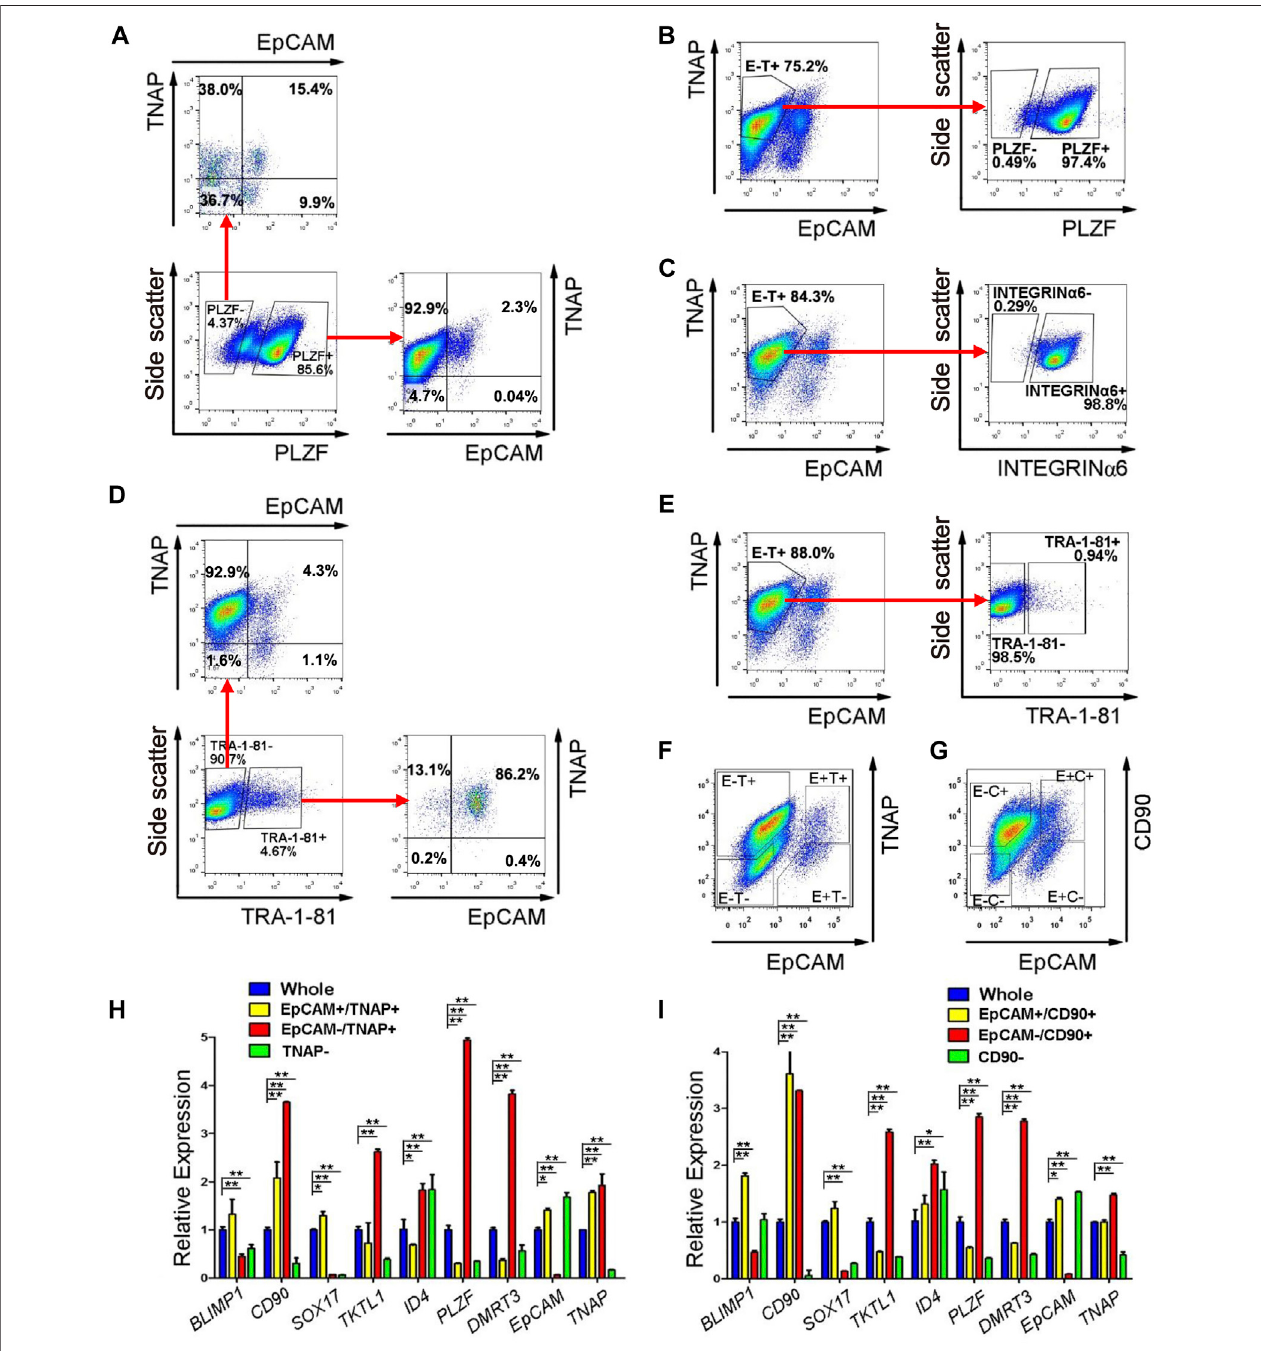
FIGURE 4 | EpCAM-/TNAP+ population is enriched with SLCs differentiated from human PSCs. (A) Flow cytometry analyses of EpCAM and TNAP expression in PLZF positive and negative populations from PSCs. (B,C,E) Percentage of PLZF (B) , INTEGRIN α 6 (C) , and TRA-1-81 (E) in EpCAM-/TNAP+ population differentiated fromhumanPSCs,analyzedby fl owcytometry. (D) FlowcytometryanalysesofEpCAMandTNAPexpressioninTRA-1-81positiveandnegativepopulationsfromPSCs. (F – G) Fluorescence-activated cell sorting was conducted, using EpCAM and TNAP combination (F) , or with EpCAM and CD90 antibodies (G) . E, EpCAM; T: TNAP; C: CD90 (H – I) Real-time RT-PCR analyses of germ cell-speci fi c genes on populations sorted with EpCAM and TNAP (H) or with EpCAM and CD90 staining (I) . Data represent as the mean ± SEM (n ≥ 3). *: p < 0.05; **: p < 0.01. Negative gating controls were shown in Supplementary Figure S5 .